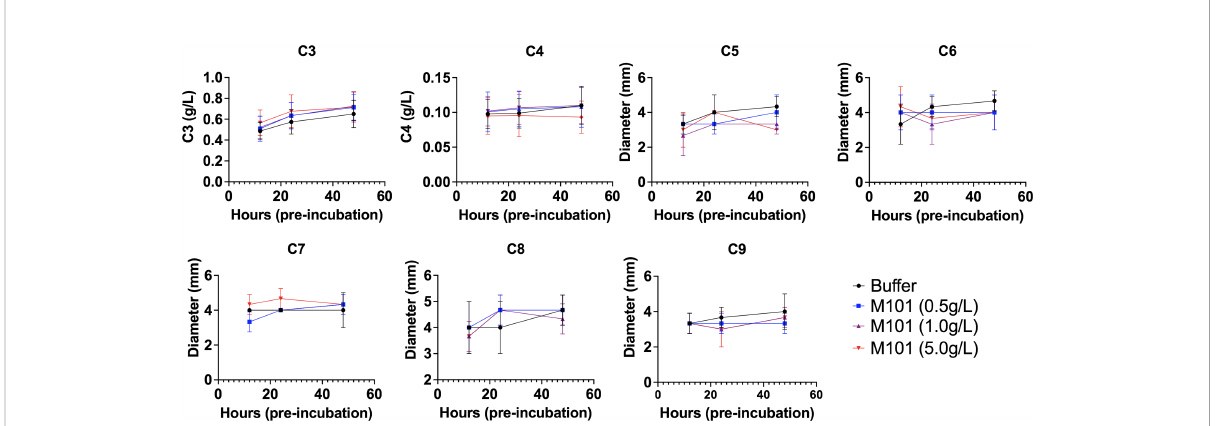
FIGURE 4 No proteolytic action of M101 on C3 to C9 fractions. EDTA whole blood from healthy controls was pre-incubated with increasing amounts of M101 (buffer, 0.5 g/L, 1 g/L and 5 g/L) during 12h, 24h and 48h before being centrifuged and EDTA-plasma frozen (-80°C). C3 and C4 fractions were quanti fi ed by turbidimetry (n=10), results are expressed as g/L, while radial immunodiffusion (n=3) was used for the fractions C5 to C9 and results were expressed as the diameter of the ring (mm). Statistical analysis did not reach signi fi cance.